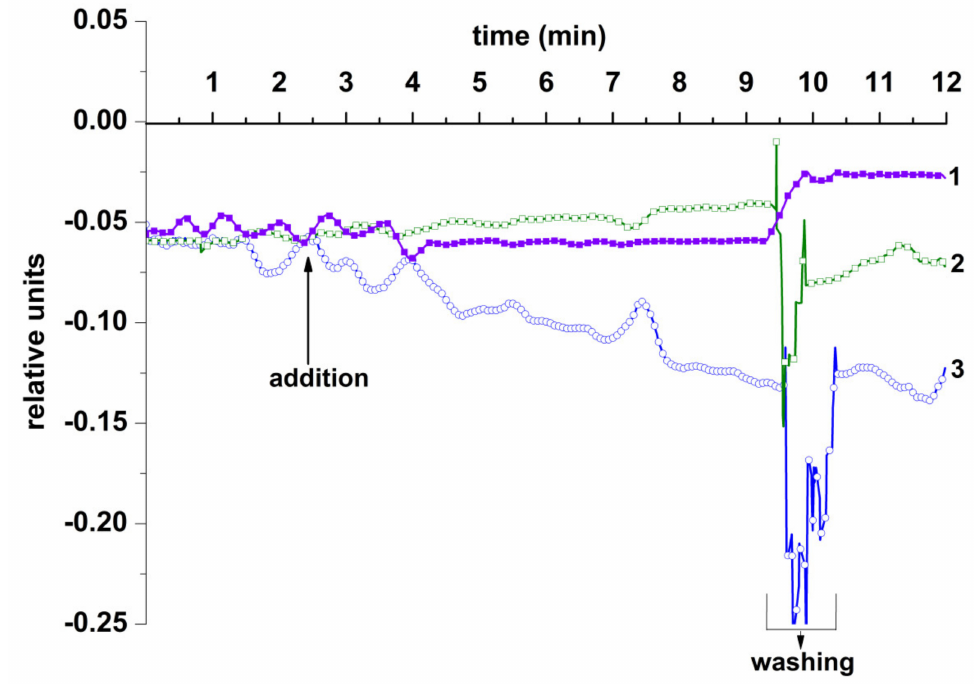
Figure 6. Typical time dependencies of the biosensor signal, obtained upon the detection of synthetic oDNA analog of spectrum disorder (ASD)-associated miRNA in 1 mM KP buffer solution with an n-type Si-NR chip: control experiment with the use of pure oDNA-free 1 mM KP buffer (curve 1); the signal from the NR, sensitized with oDNA probe_2 (specific against breast cancer markers) upon the addition of ASD-associated oDNA (curve 2); the signal from the NR, sensitized with oDNA probe_1 (specific against ASD) upon the addition of ASD-associated oDNA (curve 3). Experimental conditions: concentration of the target oDNA solution in the sample 10 − 16 M; final concentration of the target oDNA in the measuring cell 3.3 × 10 − 17 M. V g = 30 V; V ds = 0.2 V; 150 µ L volume of added sample; 450 µ L total solution volume in the